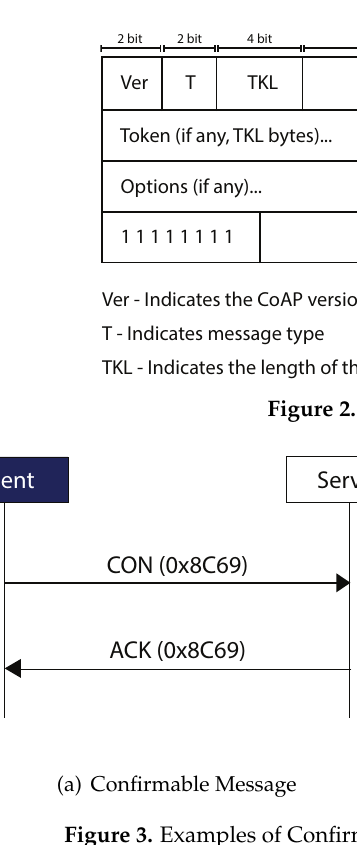
Figure 3. Examples of Confirmable and Non-confirmable CoAP messages.